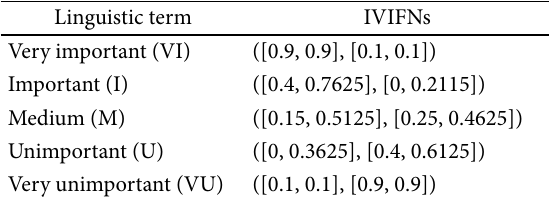
Table 4. Linguistic terms for rating the importance of criteria Linguistic term iviFNs very important (vi)